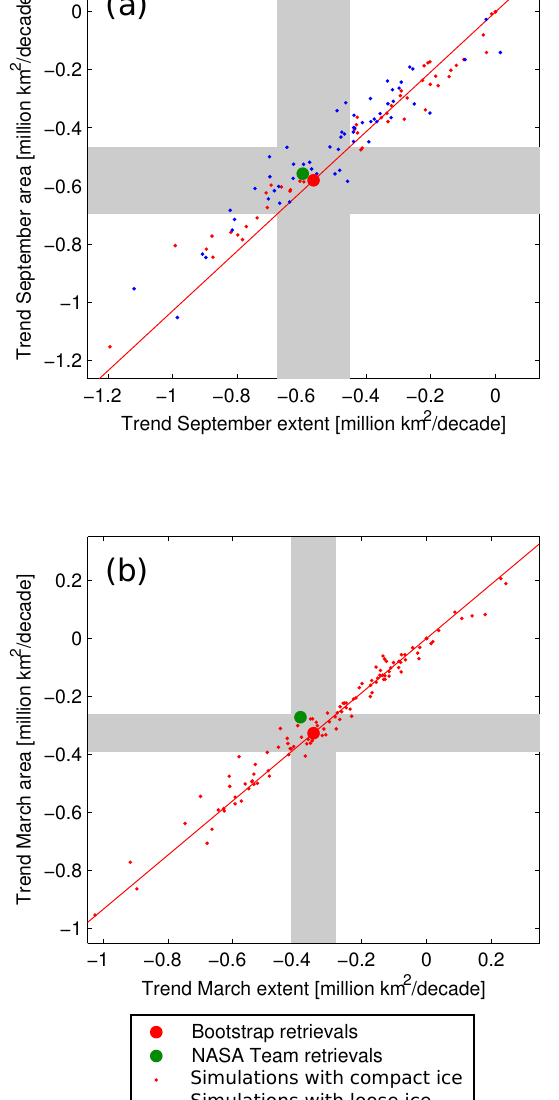
Fig. 9. (a) September and (b) March trends in sea-ice area vs. trends in sea-ice extent for the period 1979–2005. The red line connects all value pairs that have the same percentage bias in sea-ice extent and in sea-ice area relative to the Bootstrap retrievals. The gray shad- ing indicates a ± 20% range around the trends obtained from the Bootstrap retrievals.